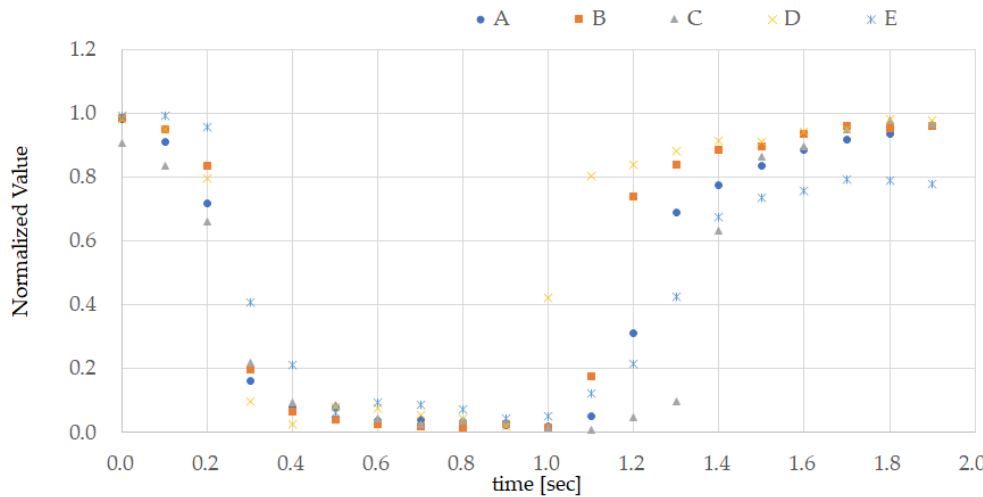
Figure 6. Ground truth of the persons (A–E) being tested. Ground truth is also obtained for the persons (B–E) being tested in the same manner as in Figure 5, and the results are superimposed and displayed. The measured values were obtained from the experiment discussed in Section 3.2.